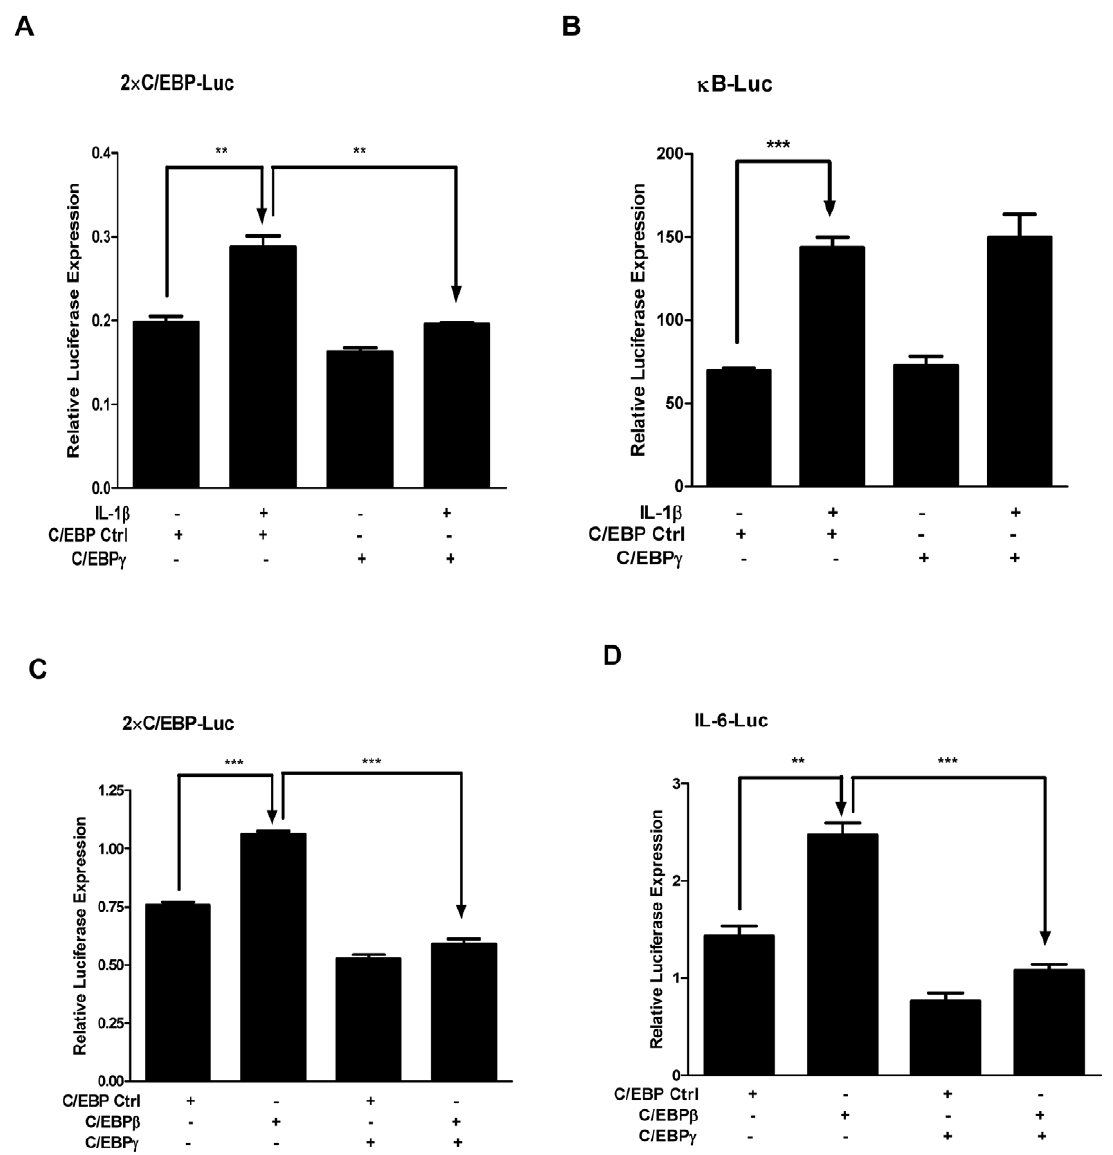
Figure 7. C/EBP c suppresses IL-1 b -induced IL-6 expression by inhibiting C/EBP b , not NF- k B activation in MLE 12 cells. A–D, MLE12 cells were transfected with indicated plasmids. 24 h later, cells were treated with or without 20 ng/ml IL-1 b . The cell lysates were subjected for luciferase activity measurement. Luminometer values were normalized for expression from a co-transfected thymidine kinase reporter gene. The data were expressed as means of three experiments 6 S. E. M. ** and *** indicated statistically significant difference- p , 0.01 and p , 0.001,